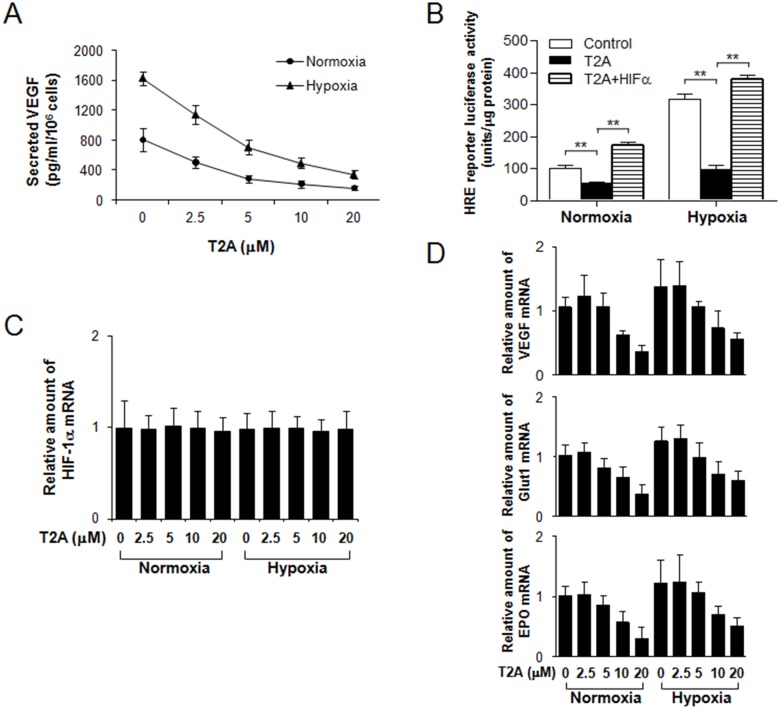
T2A inhibited the transcriptional activity of HIF-1α, but had no significant effects on the HIF-1α mRNA level.(A) The MDA-MB-231 cells were treated without or with various concentrations of T2A for 24 hour under normoxic or hypoxic conditions. VEGF in the supernatant was evaluated using ELISA. Error bars represent means ± S.D. (n = 3). (B) The MDA-MB-231 cells were transfected with pBI-GL V6L plasmid, pRL-SV-40 plasmid and HIF-1α plasmid (HIF-1α overexpression group) or an empty vector plasmid (control). Cells were treated with T2A or DMSO. The promoter activity of HIF-1α was analyzed as described in the Methods section. **P< 0.01 compared with the control. (C and D) Total cellular RNA was extracted and the HIF-1α, VEGF, Glut1, and EPO mRNA levels were evaluated using real-time PCR. The relative mRNA levels of HIF-1α, VEGF, Glut1, and EPO were normalized according to the β-actin abundance and expressed as percentages of the control. Error bars represent means ± SD (n = 3).